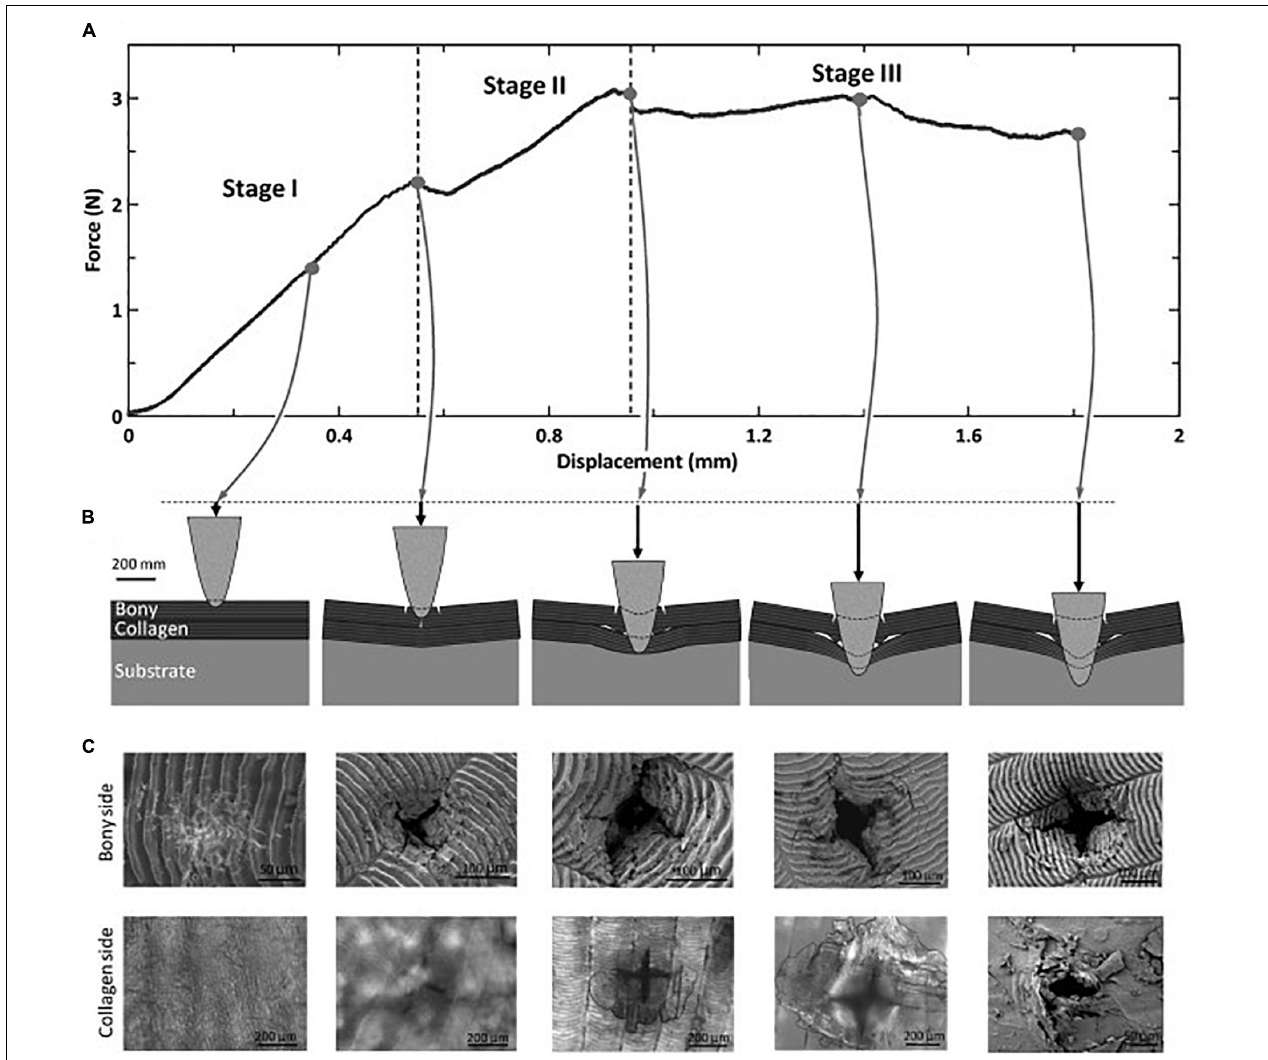
FIGURE 13 | Detailed illustration of puncture from the sharp projectile into the scale with a soft substrate (Zhu et al., 2012).